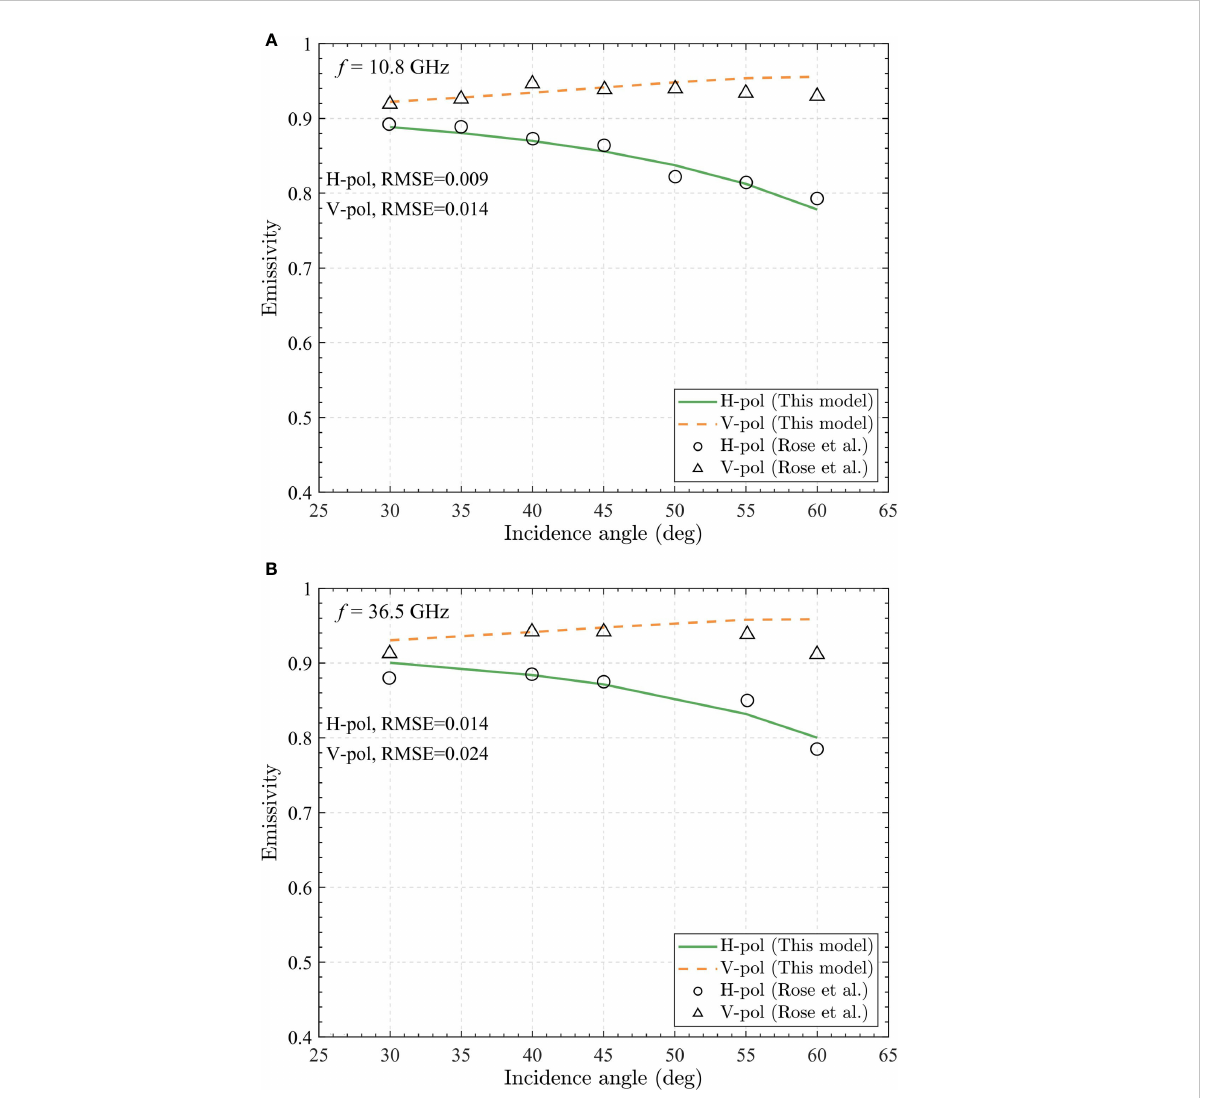
FIGURE 8 Comparison of the foam emissivity calculated with the present model to the experimental data (Rose et al., 2002, symbols) at two frequencies: (A) 10.8 GHz; (B) 36.5